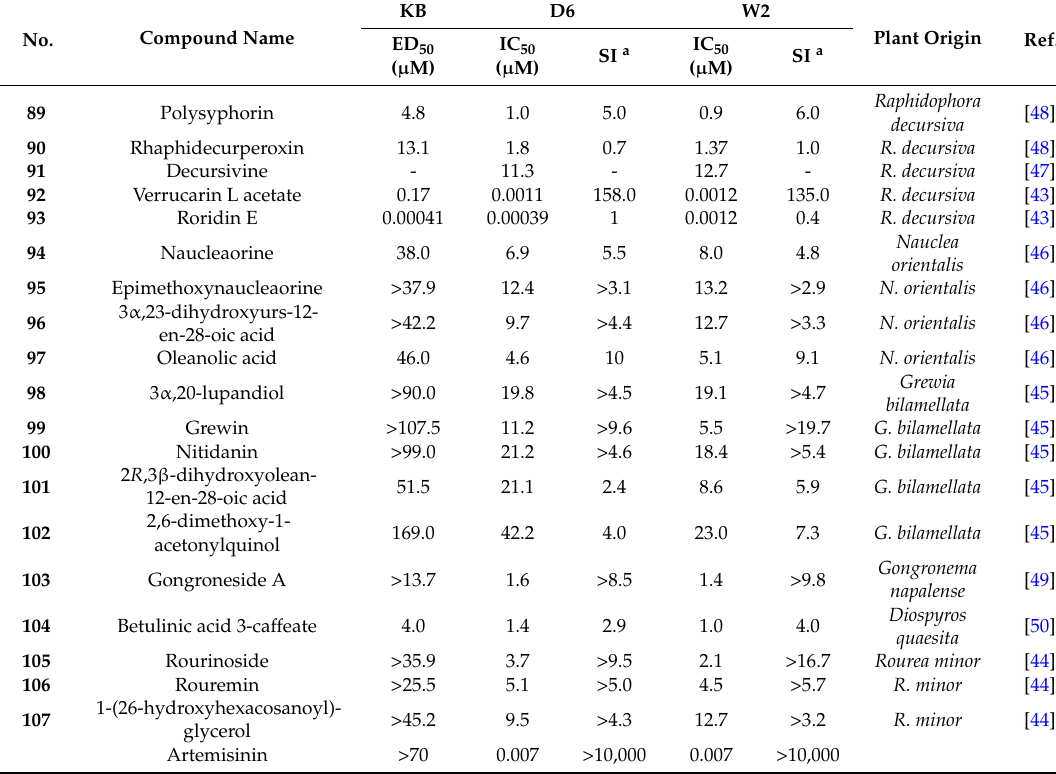
Table 4. The antimalarial activity of compounds 89 – 107